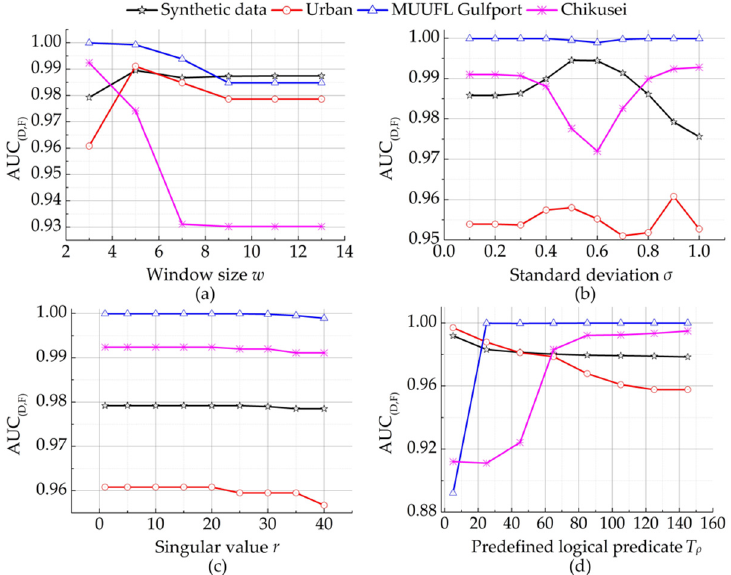
Figure 7. The influence of different parameters on the detection performance of the proposed method: ( a ) window size w ; ( b ) standard deviation σ ; ( c ) singular values r ; ( d ) predefined logical predicate T ρ .